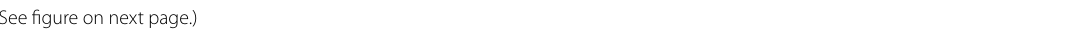
Fig. 3 CD44 depletion impacts exosome biogenesis and weakens the CAV1-dependent exosome uptake. (A-D) The characteristics of mouse plasma exosomes 1 week after MI. A Transmission electron microscopy (TEM) identified WTMI and KOMI plasma exosomes. Black arrows showed exosomes. Scale bar: 100 nm. B Plasma exosomes extracted from the WTSham, KOSham, WTMI, and KOMI groups were examined with Western blot analysis of exosome markers (Alix, CD63, and CD81). n 3. C Nanoparticle tracking analysis (NTA) identified plasma exosomes of the WTMI and = KOMI groups. D The concentration of plasma exosomes in the WTSham (n 4), KOSham (n 5), WTMI (n 9), and KOMI (n 10) groups (left panel). = = = = The statistical data of plasma exosome sizes in the four groups (right panel). E Quantification of cardiac exosomes isolated from CD44 WT and KO injured LV measured using NTA. F Western blot analysis examined the expression of caveolin1 (CAV1) in CRISPR/Cas9-CD44 KO HUVECs and primary mouse CD44 KO MVECs. n 3. G Representative confocal microscopy images of the uptake of DiD-labeled WTMI-Exo and KOMI-Exo (red) by WT = and KO MVECs. Phalloidin marks the cytoskeleton (F-actin, green). n 6. DAPI (blue) stained cell nuclei. Scale bar: 10 μm. H Representative confocal = microscopy images of plasma exosomes internalized by primary mouse MVECs within 0 min, 15 min, and 30 min. White arrowheads showed the colocalization of CAV1 (green) and the early endosome marker early endosome antigen 1 (EEA1) (red) in MVECs. DAPI (blue) stained cell nuclei. Scale bar: 10 μm. I The colocalization analysis of F . n 11–15. * P < 0.05, ** P < 0.01, *** P < 0.001, ns =